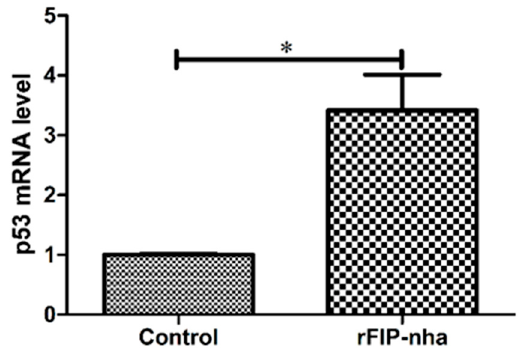
Figure 6. Analysis of differential p53 expression in A549 cells after rFIP-nha treatment. A549 cells were treated with 16 μ g/mL of rFIP-nha for 24 h, followed by RT-PCR assays to estimate p53 expression changes. Each bar represents mean ± SD ( n = 3); *: p < 0.05 compared to control (0 μ g/mL).